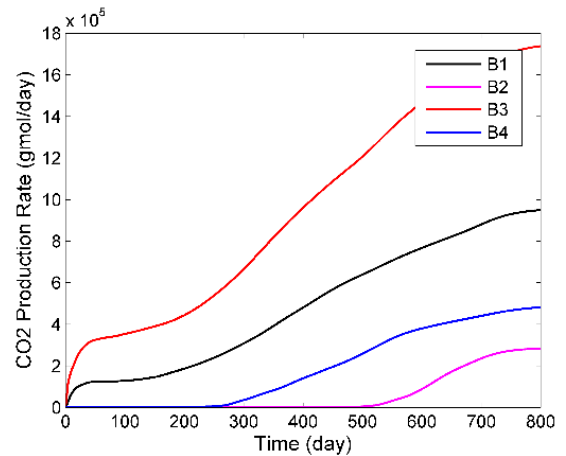
Figure 25. Adsorbed concentration of CO 2 for well pattern B after 30 days’ injection (unit: 1.0 × 10 − 3 m 3 /kg coal).